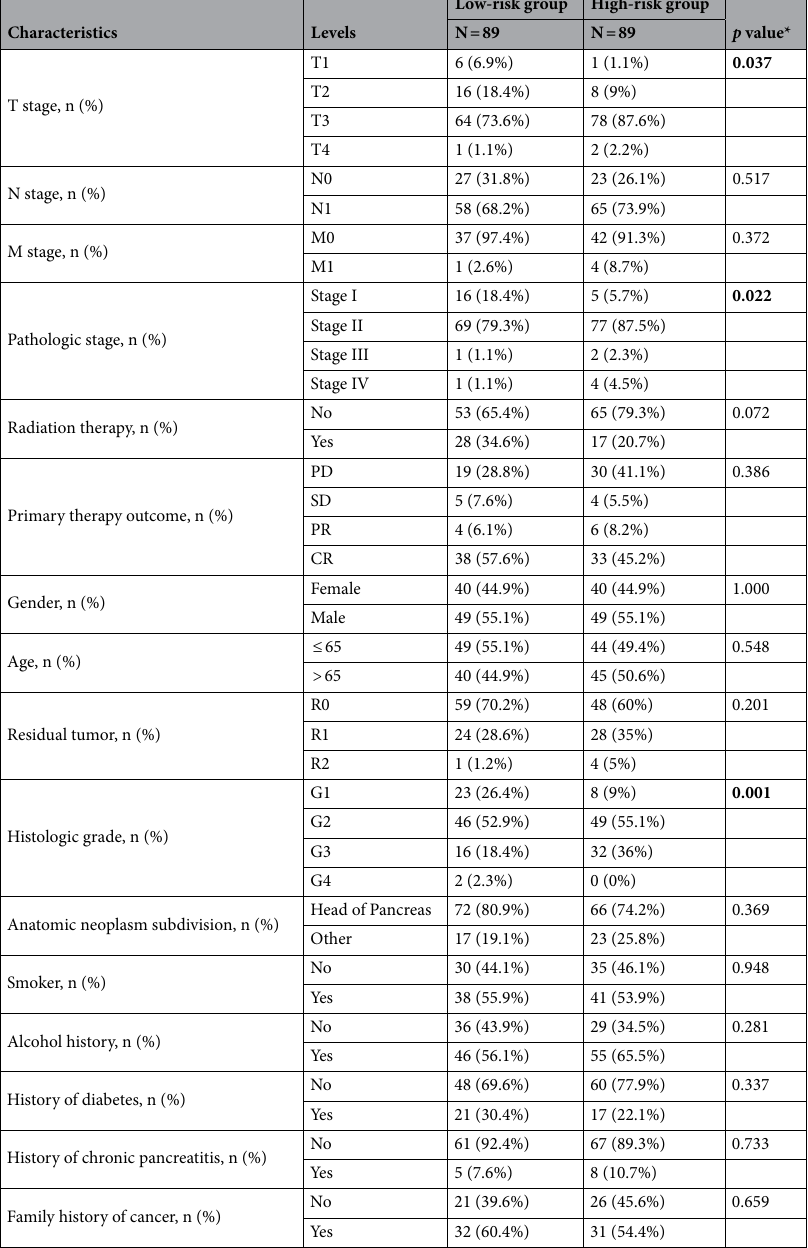
Table 1. Baseline characteristics of patients (TCGA-PAAD). Data are presented as n (%). PAAD pancreatic adenocarcinoma. *Compared with each group (Fisher exact test, or Pearson’s chi-square test). p value < 0.05 was considered statistically significant (highlighted in